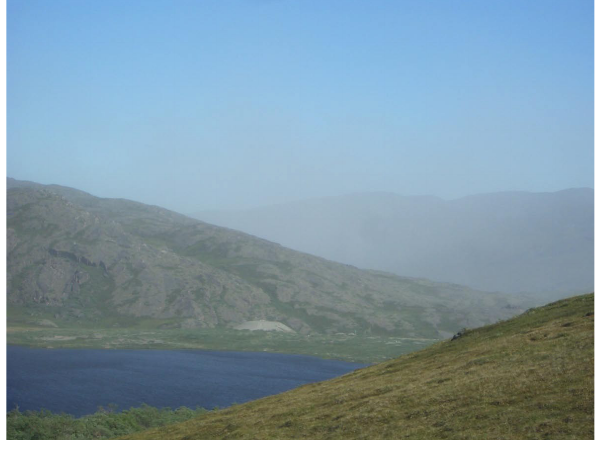
Fig. 13. A dust event has been observed at Greenland on 4 July 2008 near Kangerlussuaq, where strong winds mobilized mineral parti- cles from areas of open land. The horizontal visibility as estimated by witnesses was around